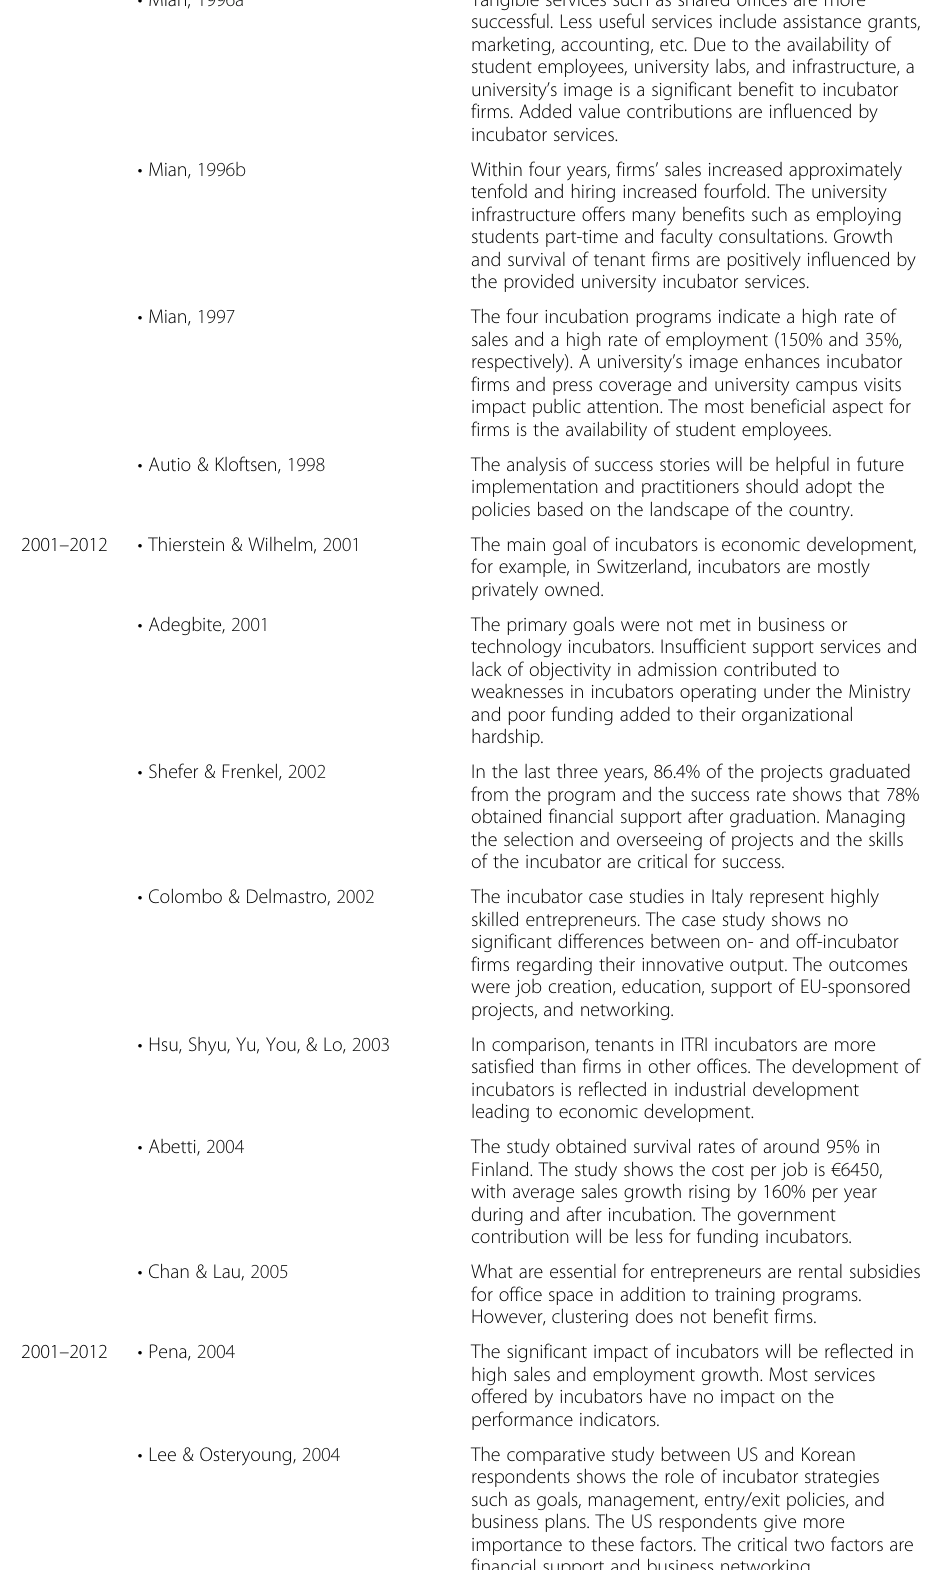
Table 1 Incubators: evidence from the literature